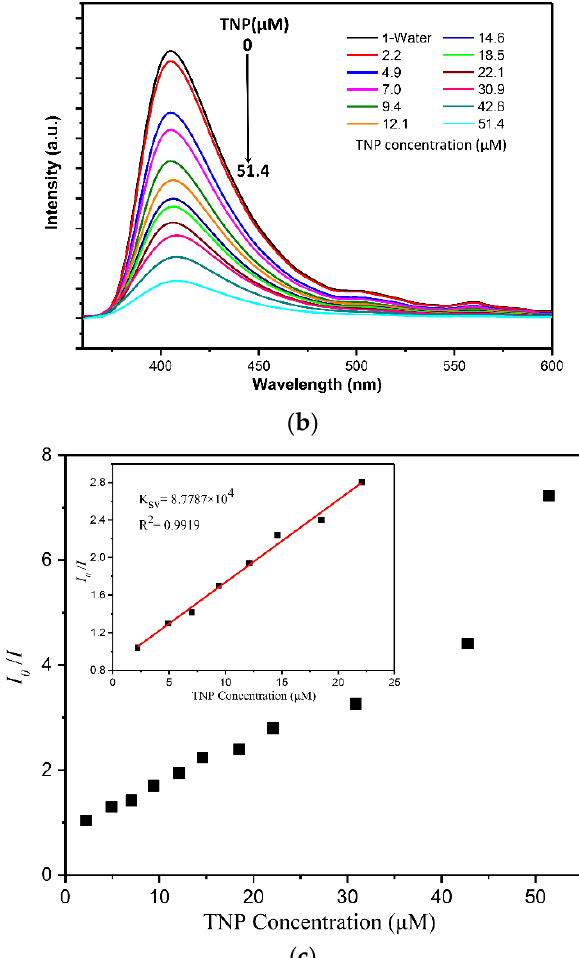
Figure 4. ( a ) Comparisons of the luminescence intensity of 1 in 50 µ M different nitro analytes suspension in aqueous phase. ( b ) The luminescence spectra dispersed in water were titrated at room temperature by adding different concentrations of 2,4,6-trinitrophenol (TNP) ( µ M). ( c ) Relationship between Stern-Volmer plot of I o / I and TNP concentration in 1-water suspension.